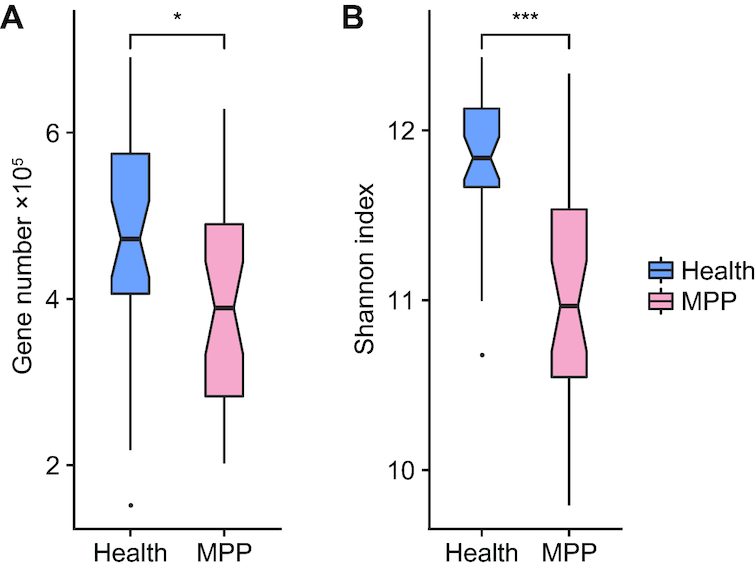
Differentiation of oropharyngeal (OP) microbial samples between healthy children and children with Mycoplasma pneumoniae pneumonia (MPP). (a) Gene counts in the OP microbiotas of healthy children and children MPP. (b) α Diversity of the OP microbiota in healthy children and children with MPP. Boxes represent the interquartile ranges (IQRs) between the first and third quartiles, and the line inside the box represents the median. Whiskers represent the lowest or highest values within values 1.5 times the IQR from the first or third quartiles. Dots represent outliers. *, *** represents P ≤ 0.05, ≤ 0.001.